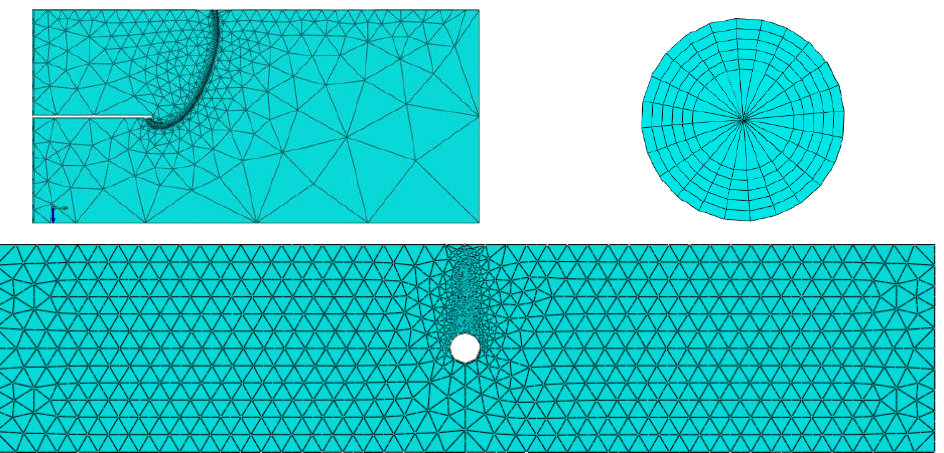
Figure 20. The finite element mesh of the entity and local crack in front of the model. The crack surface was defined by the seam method in ABAQUS, which has the same coordinates and separate nodes at the crack surface on both sides. The crack front shape was modeled by the B spline of the trace line and the anchor point number was adjusted by the trace line length shown in Figure 21.